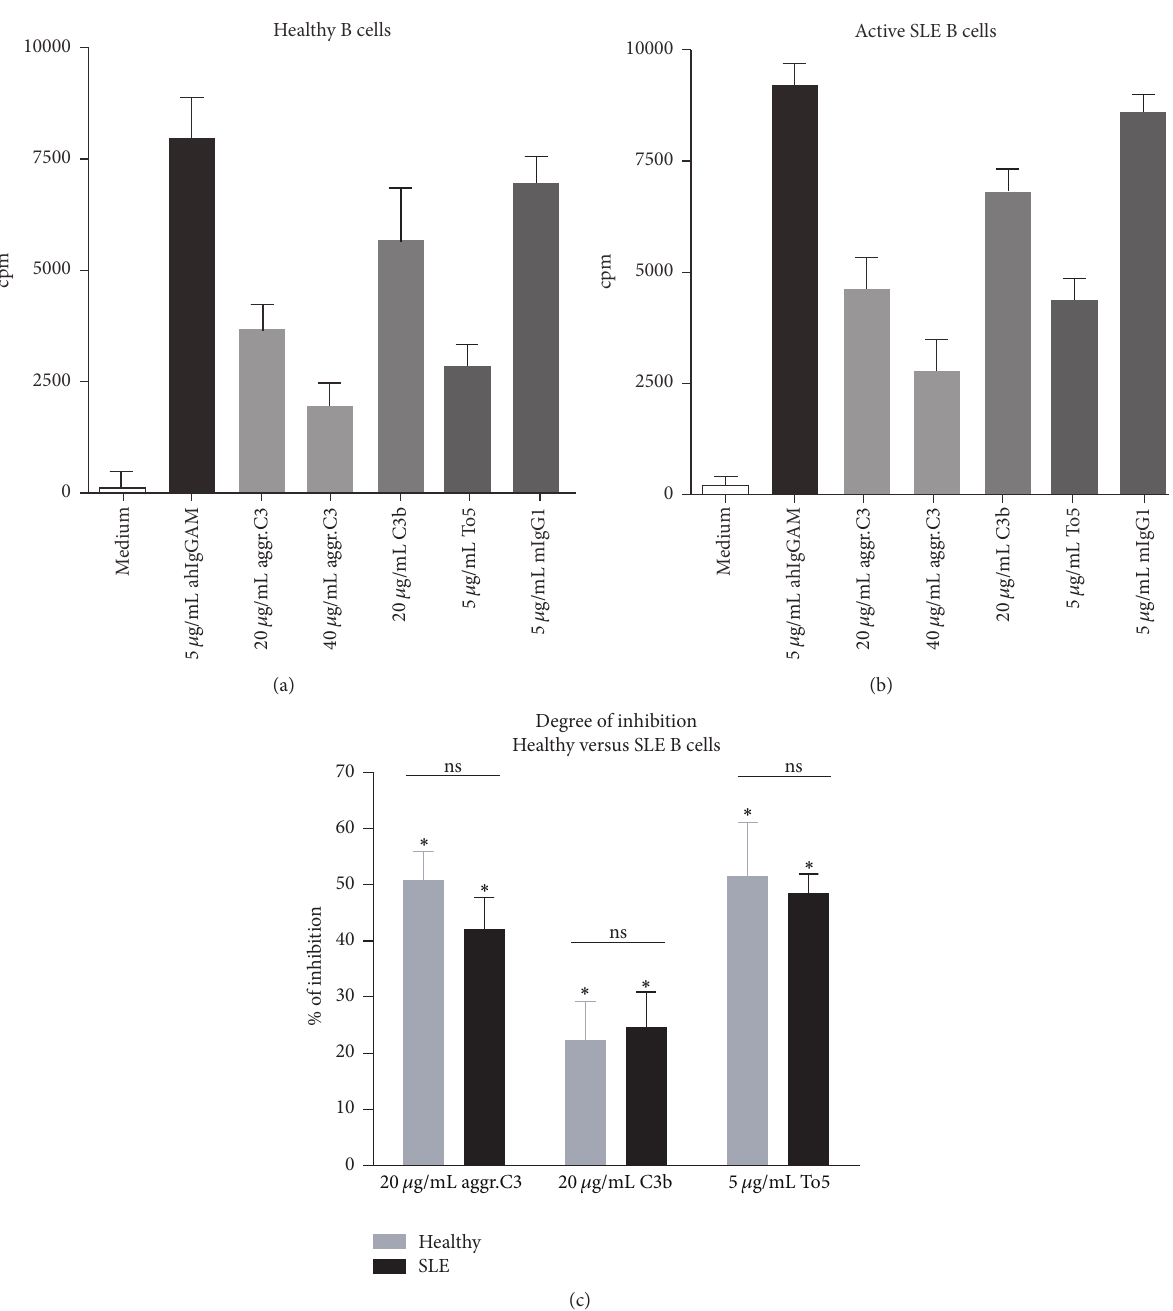
Figure 1: Impact of CR1 clustering on BCR-induced proliferation of B cells. 2 × 10 5 B cells isolated from healthy donors (a) or active SLE patients (b) were activated with 5 𝜇 g/mL F(ab’) 2 fragment of anti-human IgG+M+A Ab in the presence or absence of different concentrations of heat-aggregated C3, surface coated C3b, or the CR1-specific antibody (To5) clustered by anti-mouse IgG. As control, cells were cultured in medium or with an isotype-matched control mouse IgG. Cells were harvested after pulsing with 1 𝜇 Ci/well H 3 -thymidine for the last 16 hours of culture. (a and b) Data shown are mean ± SD cpm of triplicate cultures and representative of five independent experiments with similar results is shown. (c) Results showing percent of inhibition mediated by aggregated C3, C3b, or the anti-CR1 Ab (To5) are mean % of inhibition ± SEM of five independent experiments and correlated with the CR1-agonist untreated sample (see Section 2, Permutation-test; ∗ 𝑃 < 0.05 and ns 𝑃 > 0.05